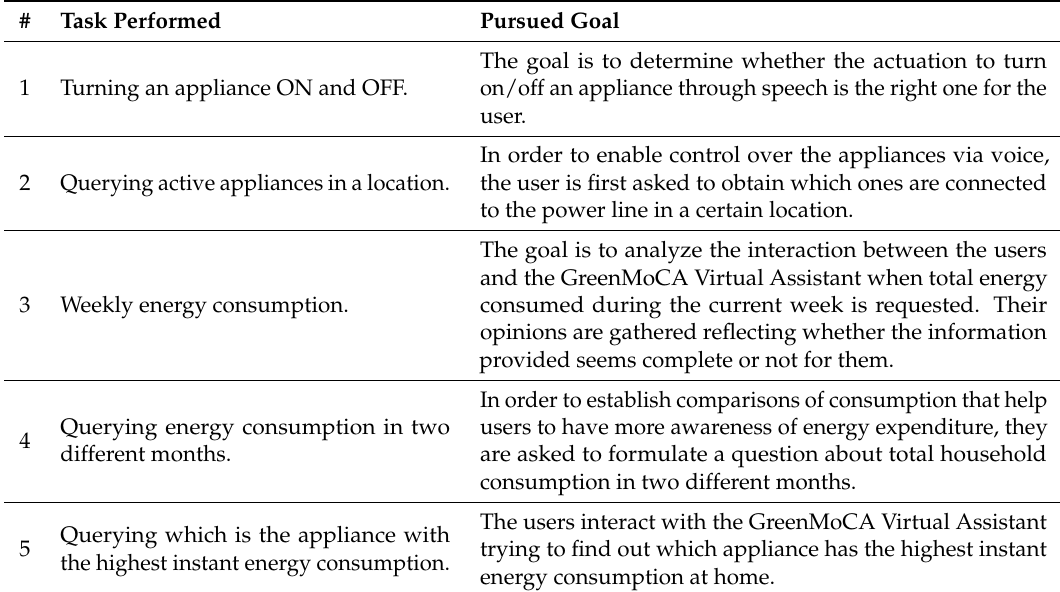
Table 1. Representative tasks performed by the participants in the usability and user experience